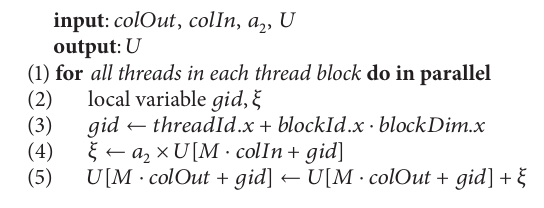
Algorithm 2: CUDA kernel for constant vector multiplication and vector vector addition.